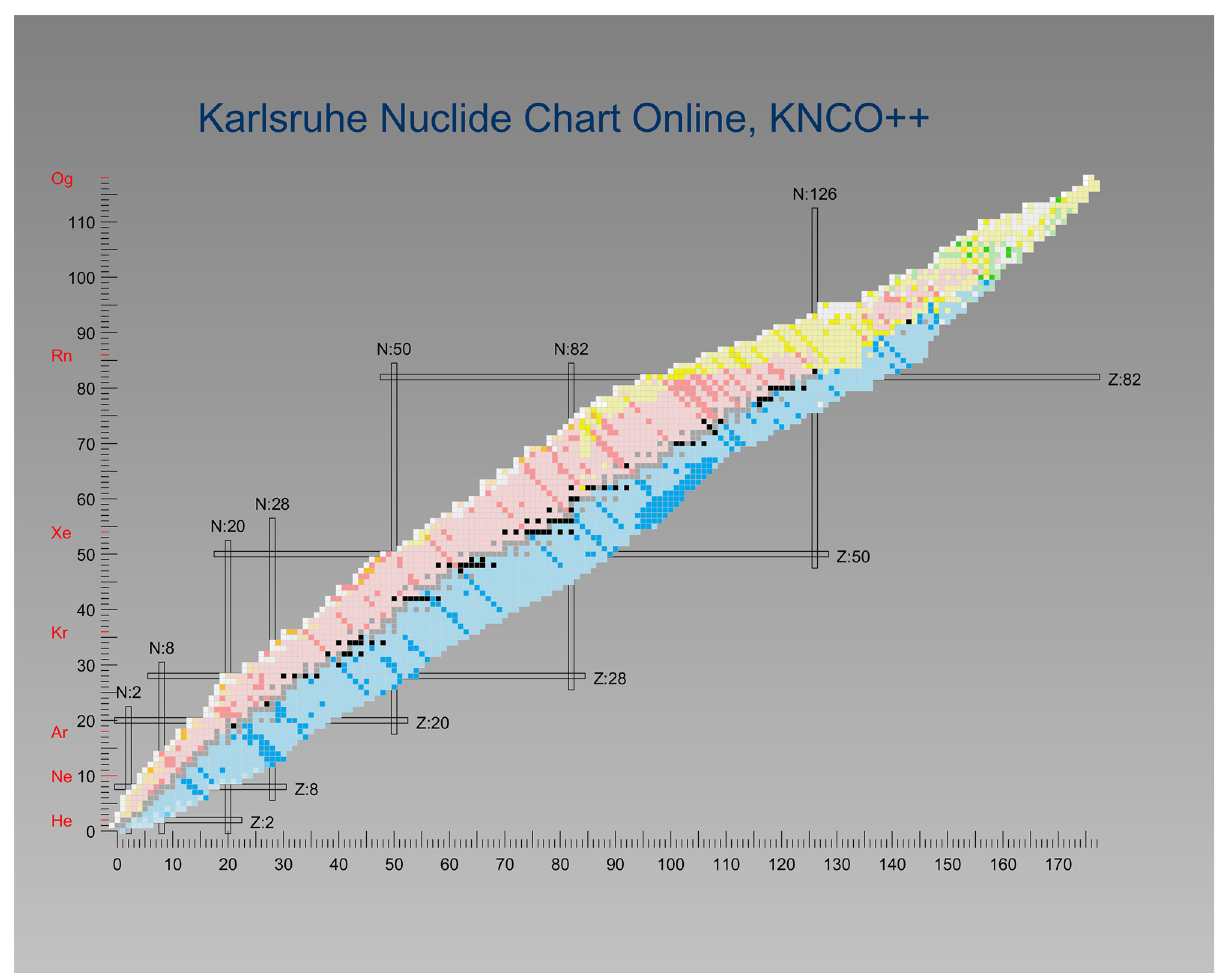
Fig. 3. The “ Difference ” Chart. The coloured boxes indicate new and updated nuclides in the 10th edition. The difference chart was created using the online version of the Karlsruhe Nuclide Chart (KNCO++) available in the nuclear science web portal Nucleonica